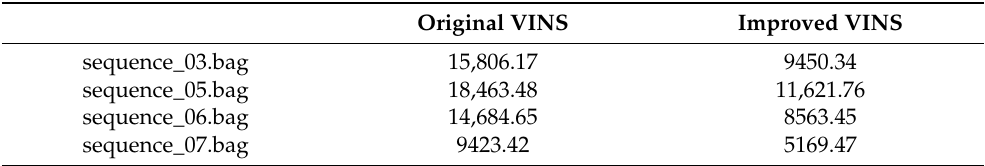
Table 9. Compare the marginalization speed between the original algorithm and the improved algorithm in the underwater dataset. (Unit: ms).